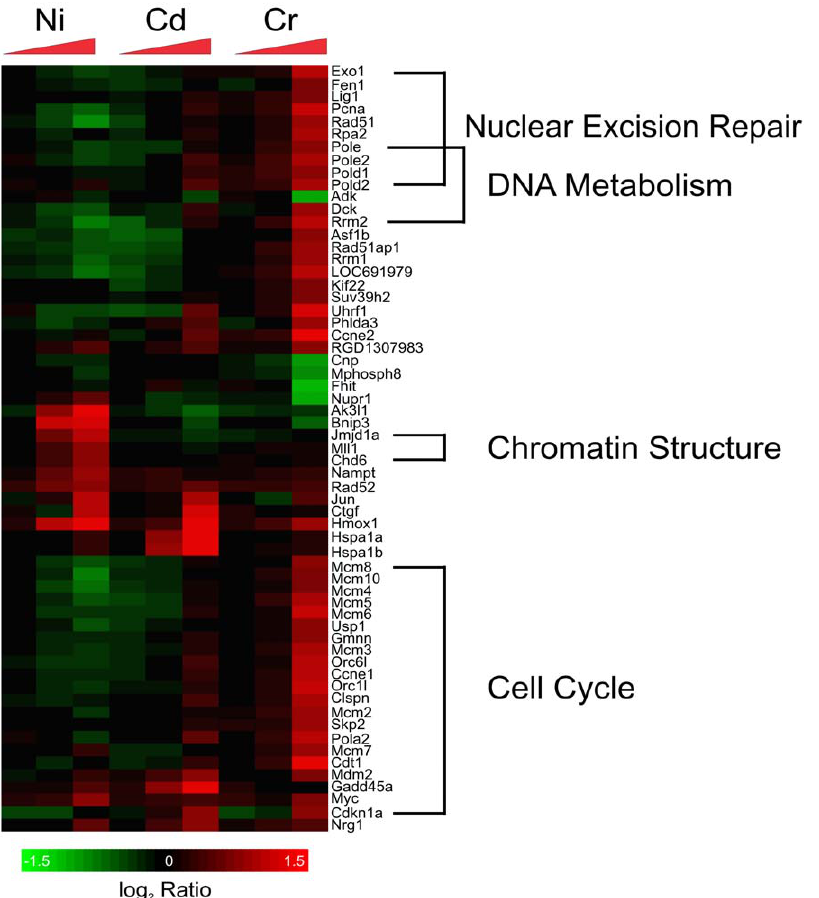
Figure 6. Expression patterns of genes involved in the response to DNA damage and chromatin structure. The expression patterns of 61 genes involved in chromatin structure or the DNA damage response are depicted. Chromium elicited the most extensive response perturbing genes involved in nuclear excision repair, DNA metabolism, and cell cycle. A number of genes involved in chromatin structure modifications were up- regulated only by nickel. The triangles indicate increasing concentrations of metals and the color indicates the log 2 ratio of control to experimental expression levels.